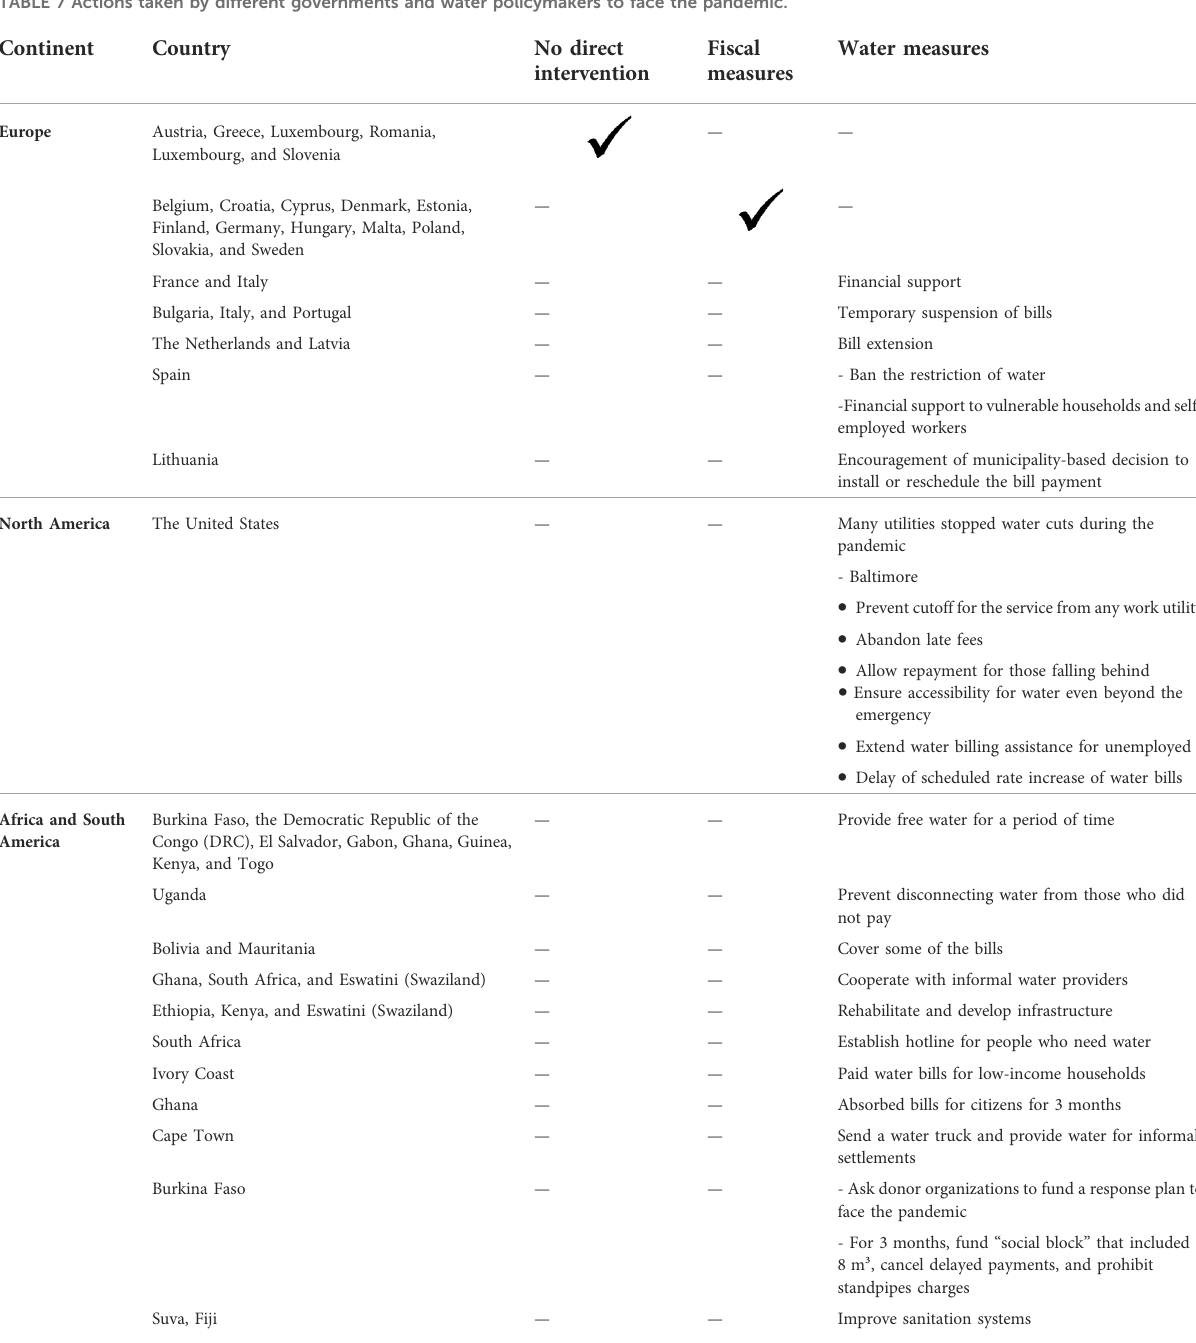
TABLE 7 Actions taken by different governments and water policymakers to face the